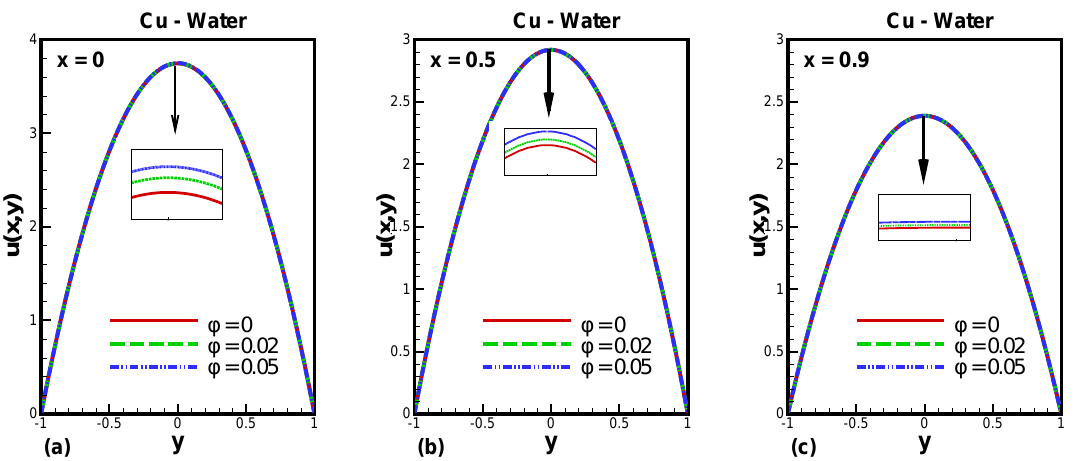
Figure 2. Effect of copper nanoparticle volume fraction φ on dimensionless longitudinal velocity at the ( a ) entrance, ( b ) middle, and ( c ) exit regions of the channel, when β = 0.5, δ = 0.2, R e = 1, and γ =